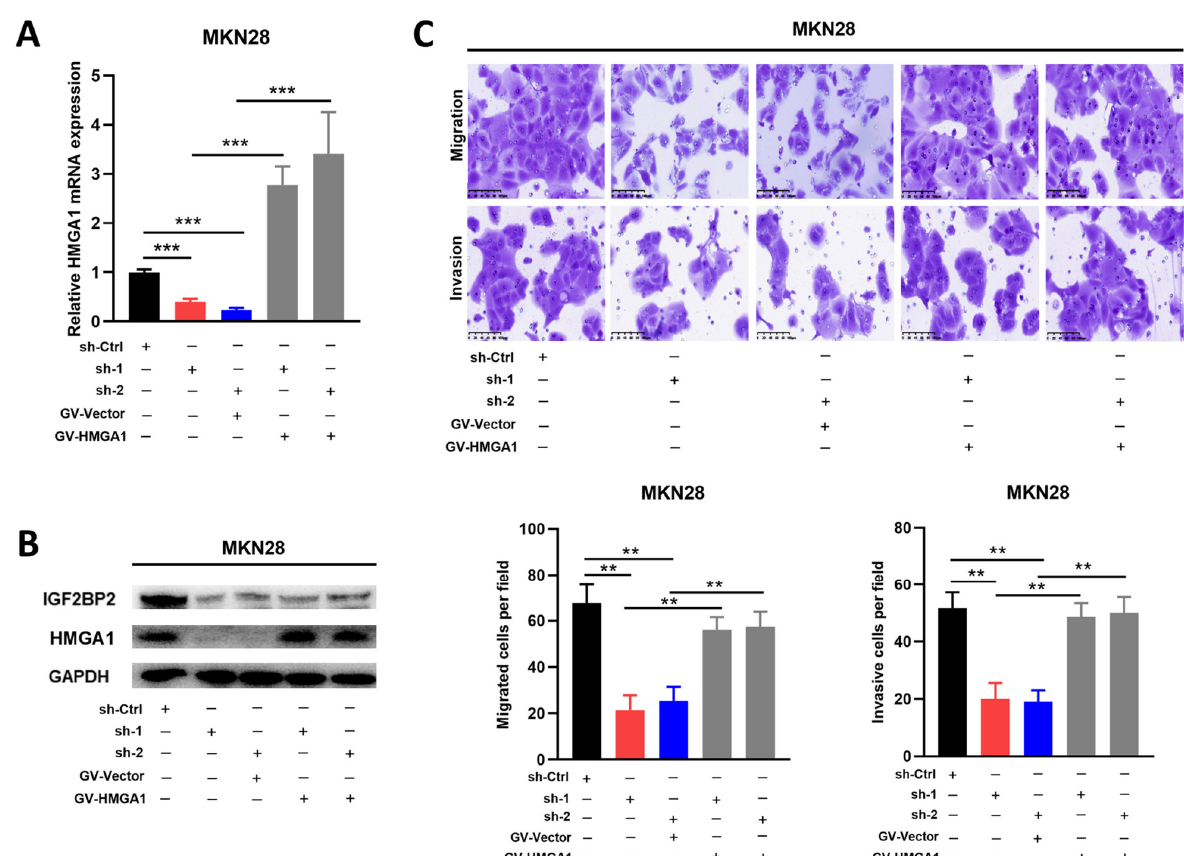
Figure 4. IGF2BP2/HMGA1 axis encourages migration and invasion capability in GC cell lines. ( A , B ) HMGA1 overexpression in MKN28 cells, in which IGF2BP2 knockdown was confirmed by Western blotting and RT-PCT analysis. ( C ) The migration and invasion capability in MKN28 GC cells re- duced by knocking down of IGF2BP2 were rescued by HMGA1 overexpression. ** p < 0.01, *** p < 0.001. Molecular weights for proteins are shown in the uncropped Western blot images (Figure